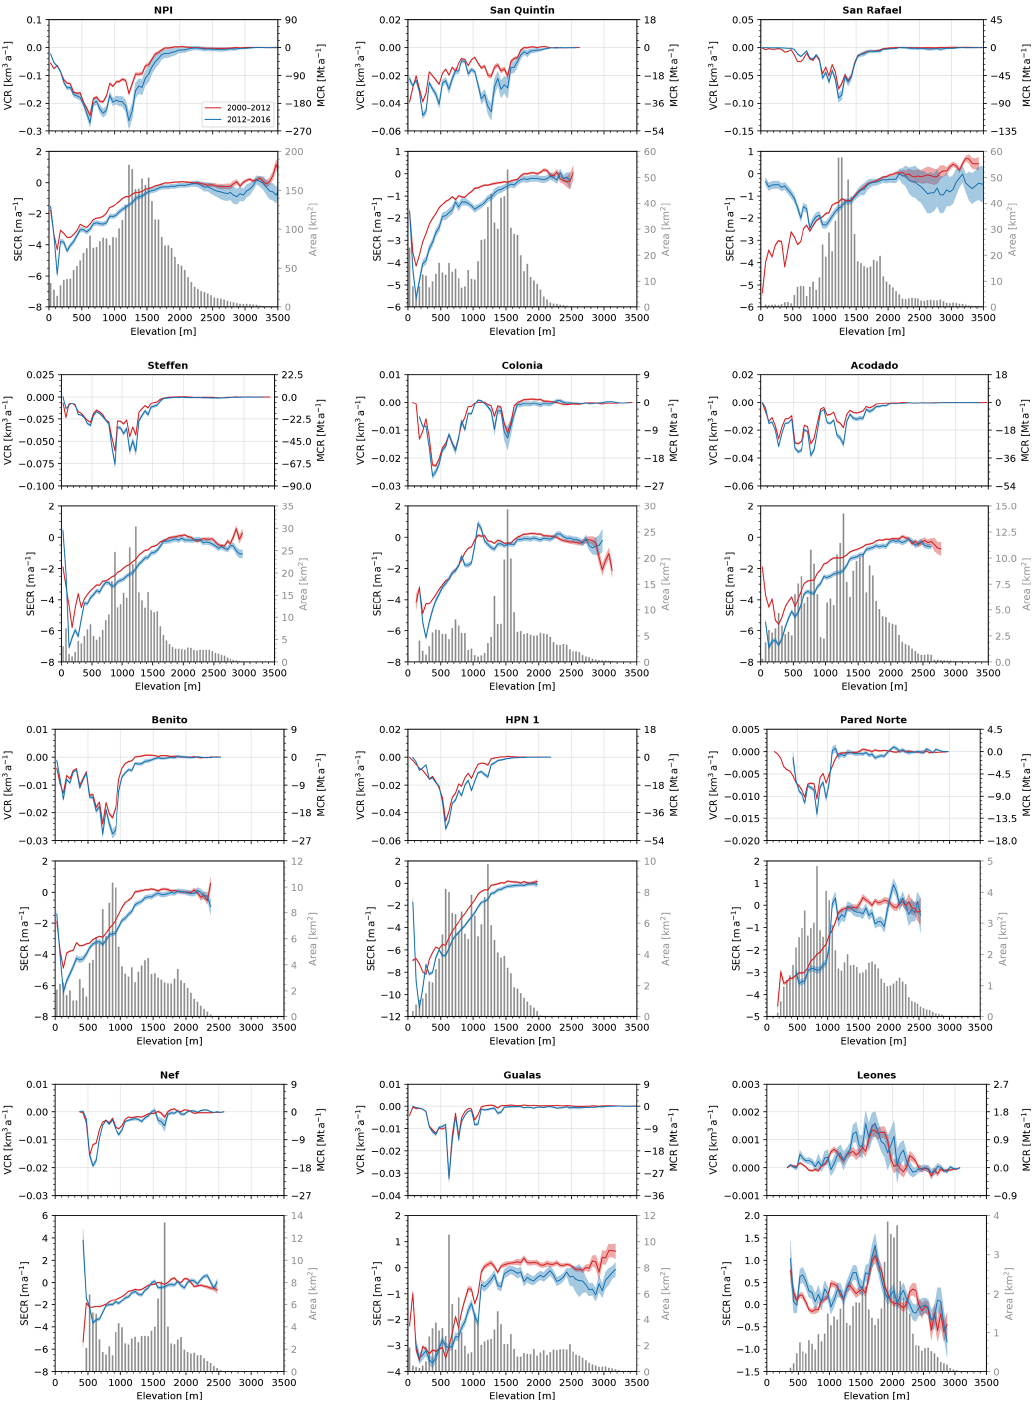
Figure 9. Surface elevation, volume and mass change rates (SECR, VCR, MCR) versus altitude in 50m intervals for NPI and its main glaciers for epochs 2000–2012 (red) and 2012–2016 (blue). The hypsometric curve of 2011/2012 is shown in grey.